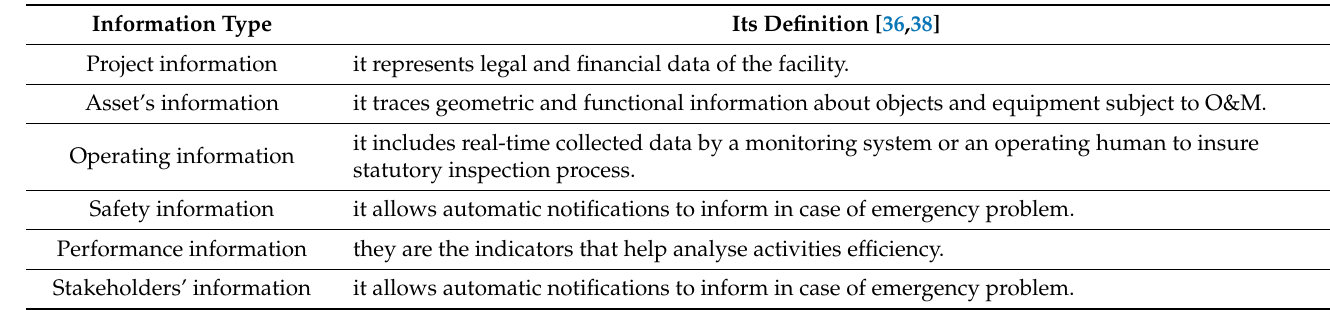
Table 2. O&M Requirements for Infrastructure